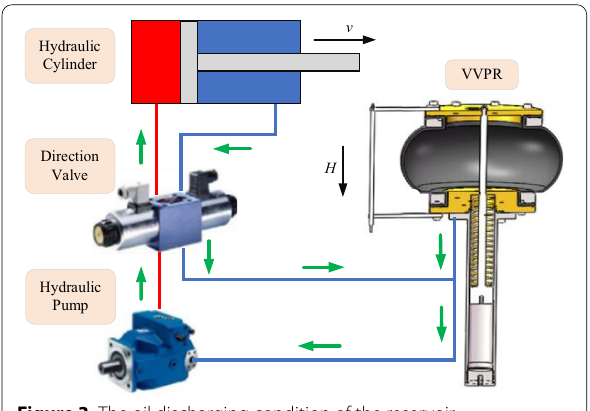
Figure 3 The oil discharging condition of the reservoir